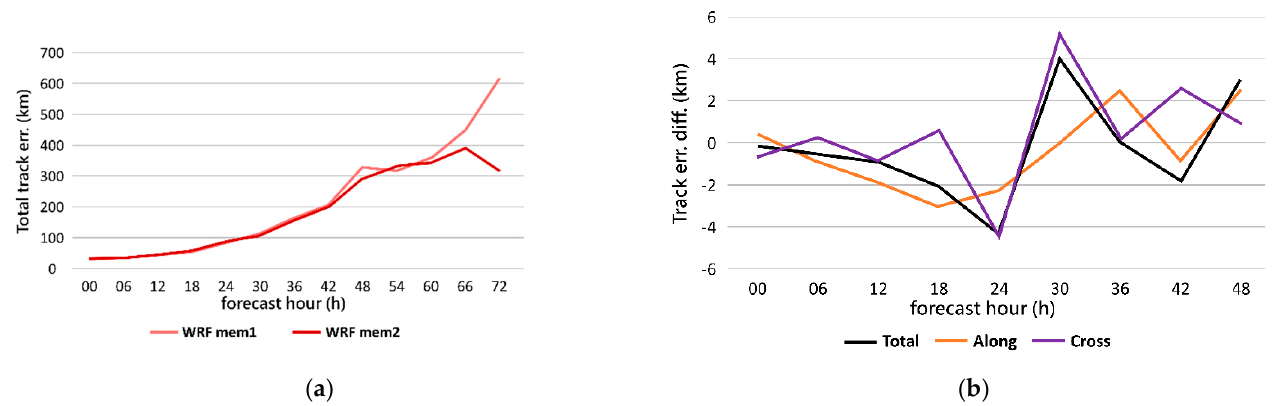
Figure 11. ( a ) The total track error within 72 h averaged over the 17 forecasts for typhoon Hagupit initialized during 12:00 UTC 1 August–12:00 UTC 5 August 2020, for WRF Members 1 (pink curve) and 2 (red curve); ( b ) the total track error difference (black curve), along-track error difference (orange curve), and cross-track error difference (purple curve) of WRF Member 1 minus WRF Member 2 within 48 h averaged over the same 17 forecasts, where positive values represent the superiority of WRF Member 2.